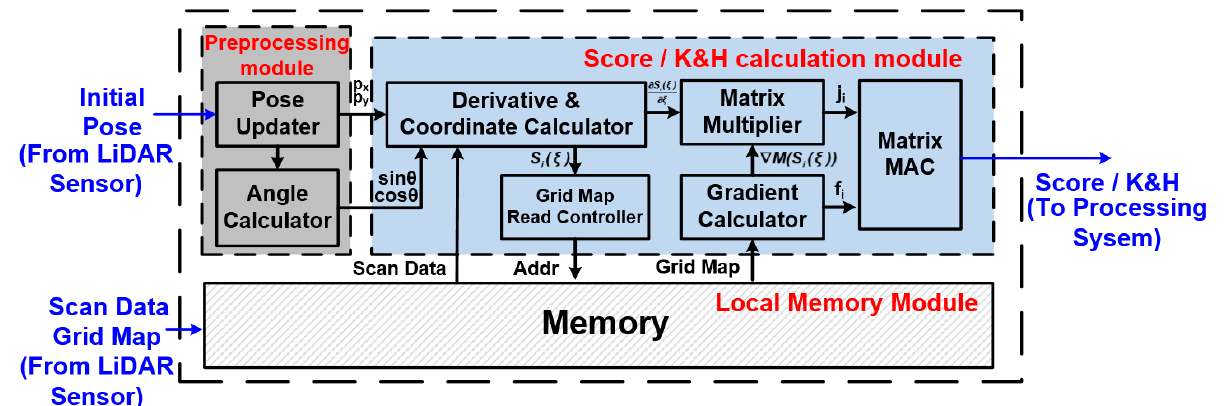
Figure 9. Overall architecture of the proposed NLO-CSM hardware accelerator design.